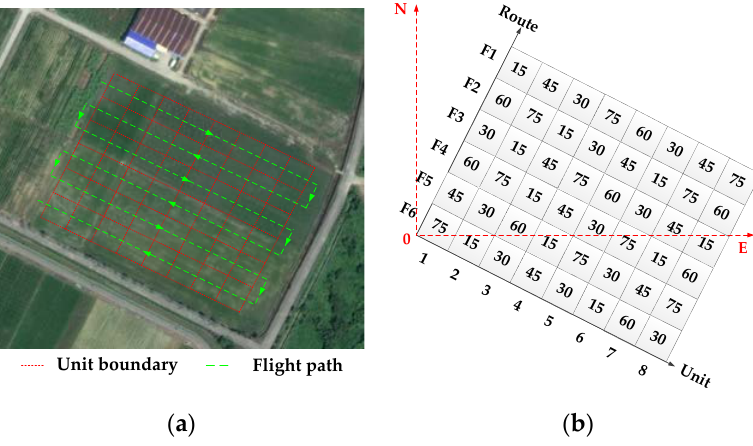
Figure 13. ( a ) Operating unit; ( b ) Prescription value of each unit.